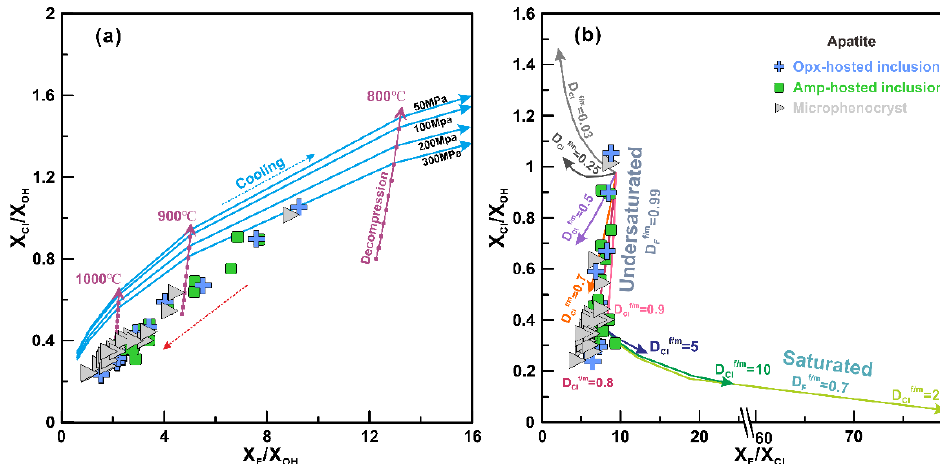
Figure 4. Volatile compositions of apatites in the studied rhyolite. ( a ) X F /X OH versus X Cl /X OH . Purple and blue arrows are the modeled trends of apatite compositional evolution at a constant melt composition under isothermal decompression and isobaric cooling conditions, respectively. The approach outlined by Stock et al. [16] was used to model the effects of physical processes such as the cooling and decompression on apatite compositions. ( b ) X F /X Cl versus X Cl /X OH . Arrows show the modeled trends of apatite composition during 80% volatile undersaturated crystallization, followed by 20% H 2 O-saturated crystallization. The various fluid–melt partition coefficients (D Clf/m ) in the thermodynamic modeling during H 2 O-undersaturated and saturated crystallization were according to Stock et al. [17]. Although the modeled results may not be quantitatively robust, these calculations provide a reference frame to outline the different processes on the apatite compositions.